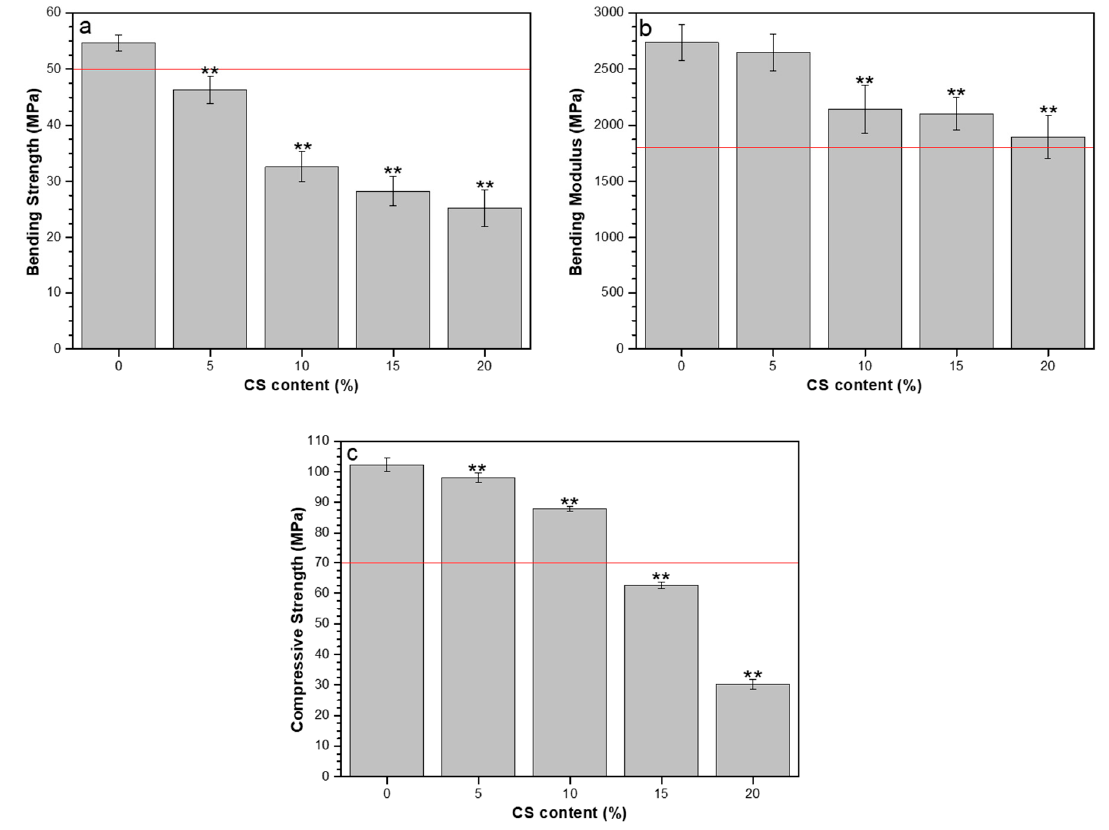
Figure 3. Mechanical properties in ABCs loaded with CS: ( a ) bending strength, ( b ) bending modulus, and ( c ) compressive strength. The straight red line corresponds to the minimum values specified in ISO 5833-02. Significance level of * p -value < 0.05; ** p -value < 0.01.